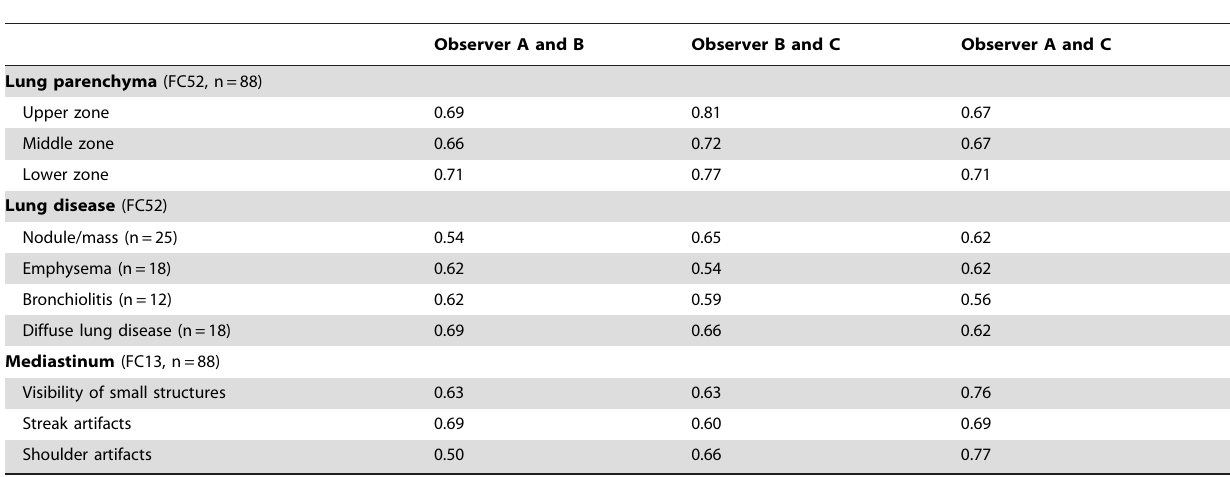
Table 1. Interobserver reproducibility ( k score) among three observers for qualitative assessment*.